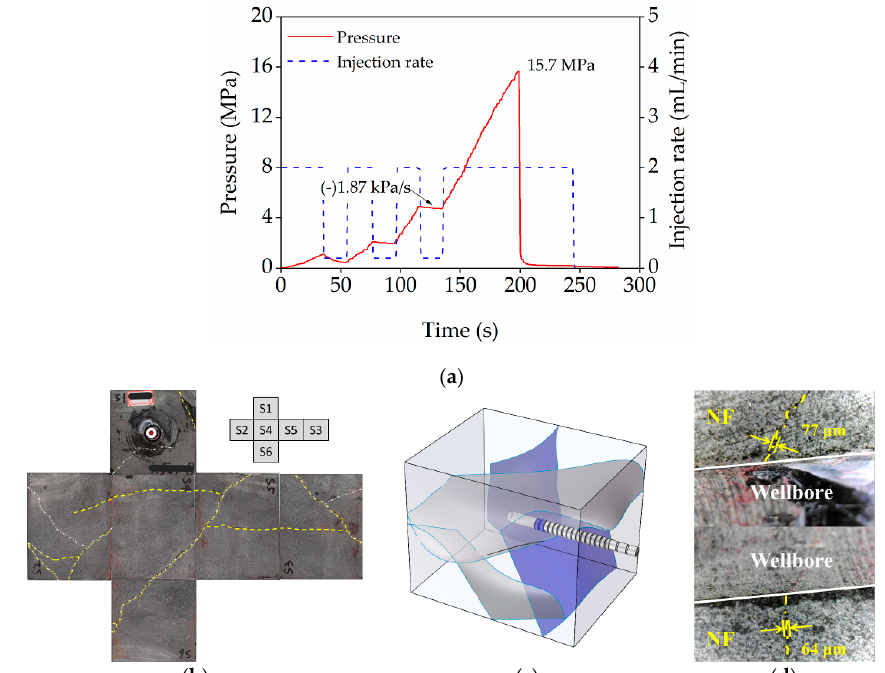
Figure 12. Fracture details of specimen No. 7: ( a ) Pressure curve, ( b ) distribution on the surface, ( c ) internal reconstruction, and ( d ) microscopy image.